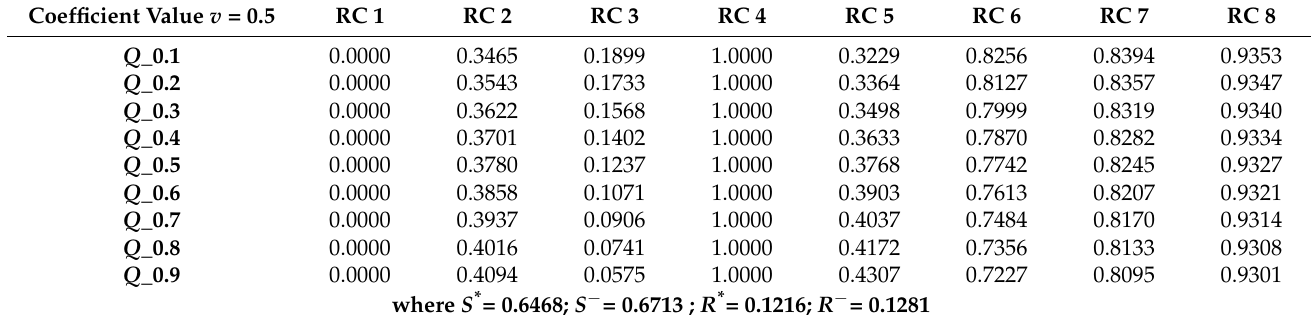
Table 12. Calculation results of benefit ratio Q j .